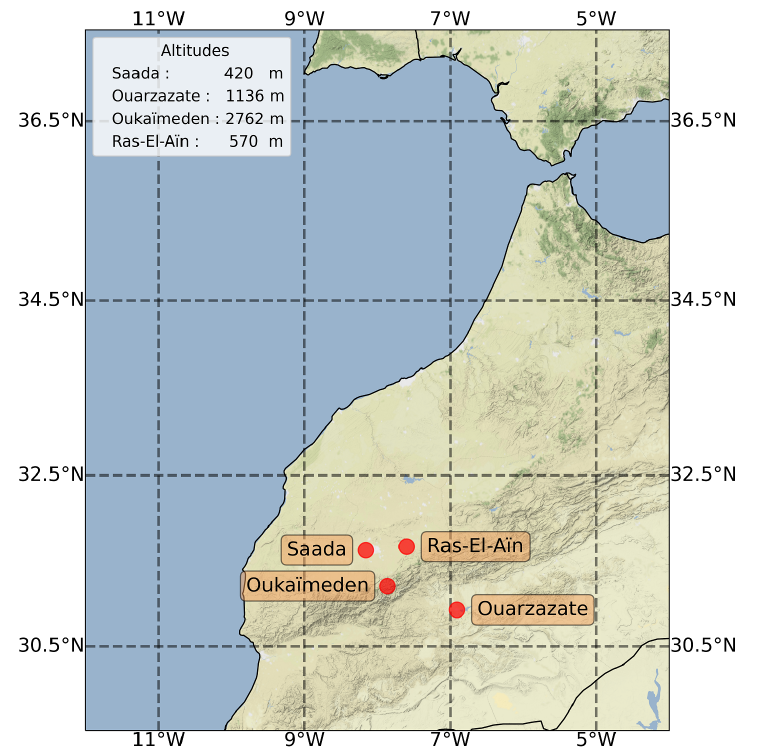
Figure 1. Geographical locations and above sea level (ASL) altitudes of the AERONET stations in southern